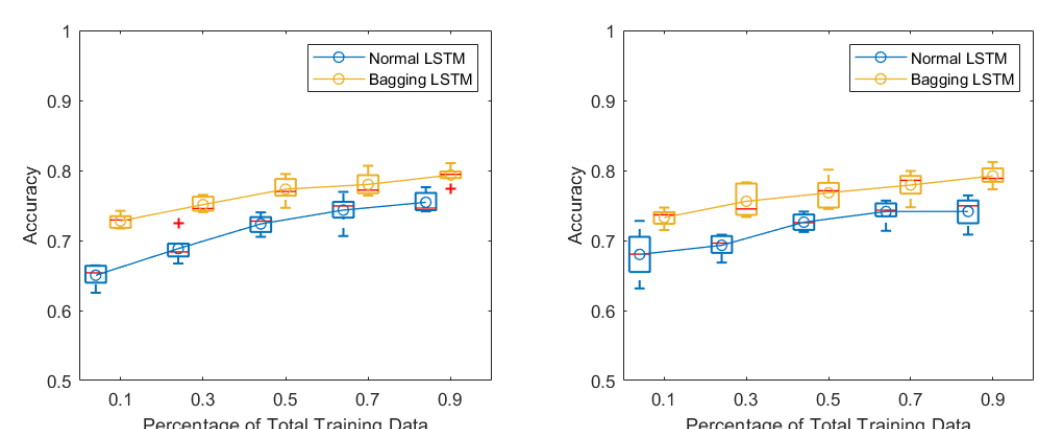
Figure 6. ( left ) Accuracy of standard LSTM vs. bagging LSTM in the performed motor task. ( right ) Accuracy of standard LSTM vs. bagging LSTM in the imagined motor task, plotted as a function of the percentage of total training data. Boxplots of 5-fold cross-validation results with medians marked by red bars and boxes referring to 1 st and 3 rd quartiles. The curves connect the means, marked by